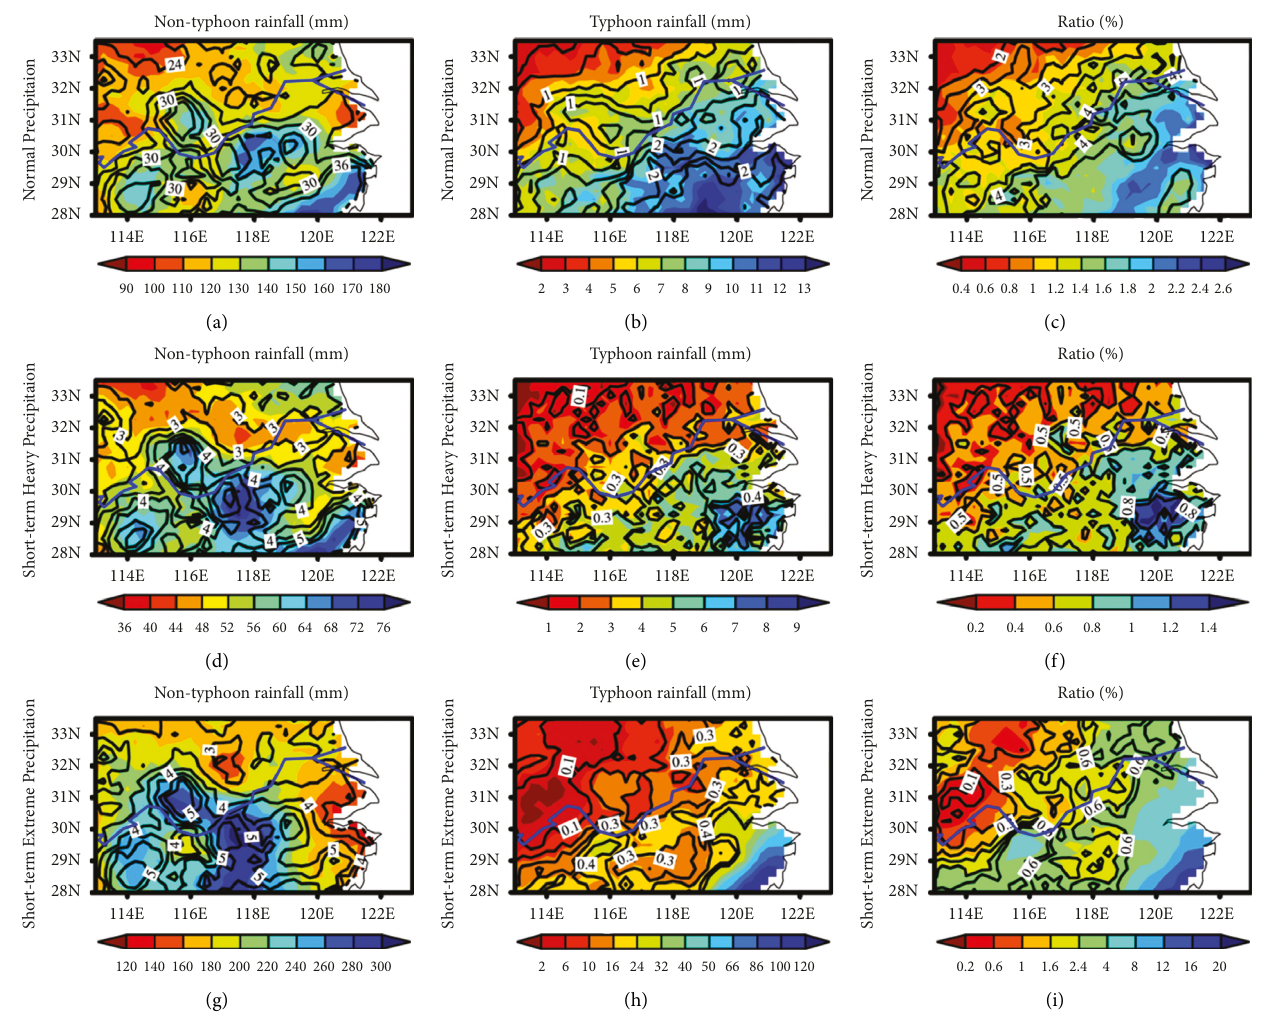
Figure 5: Spatial distribution of the summer precipitation events between 1961 and 2016. Note. The shading indicates the proportion of precipitation, the curve indicates the number of times precipitation occurred, and the ratio represents the ratio of the amount of pre- cipitation affected by the typhoons to the total precipitation